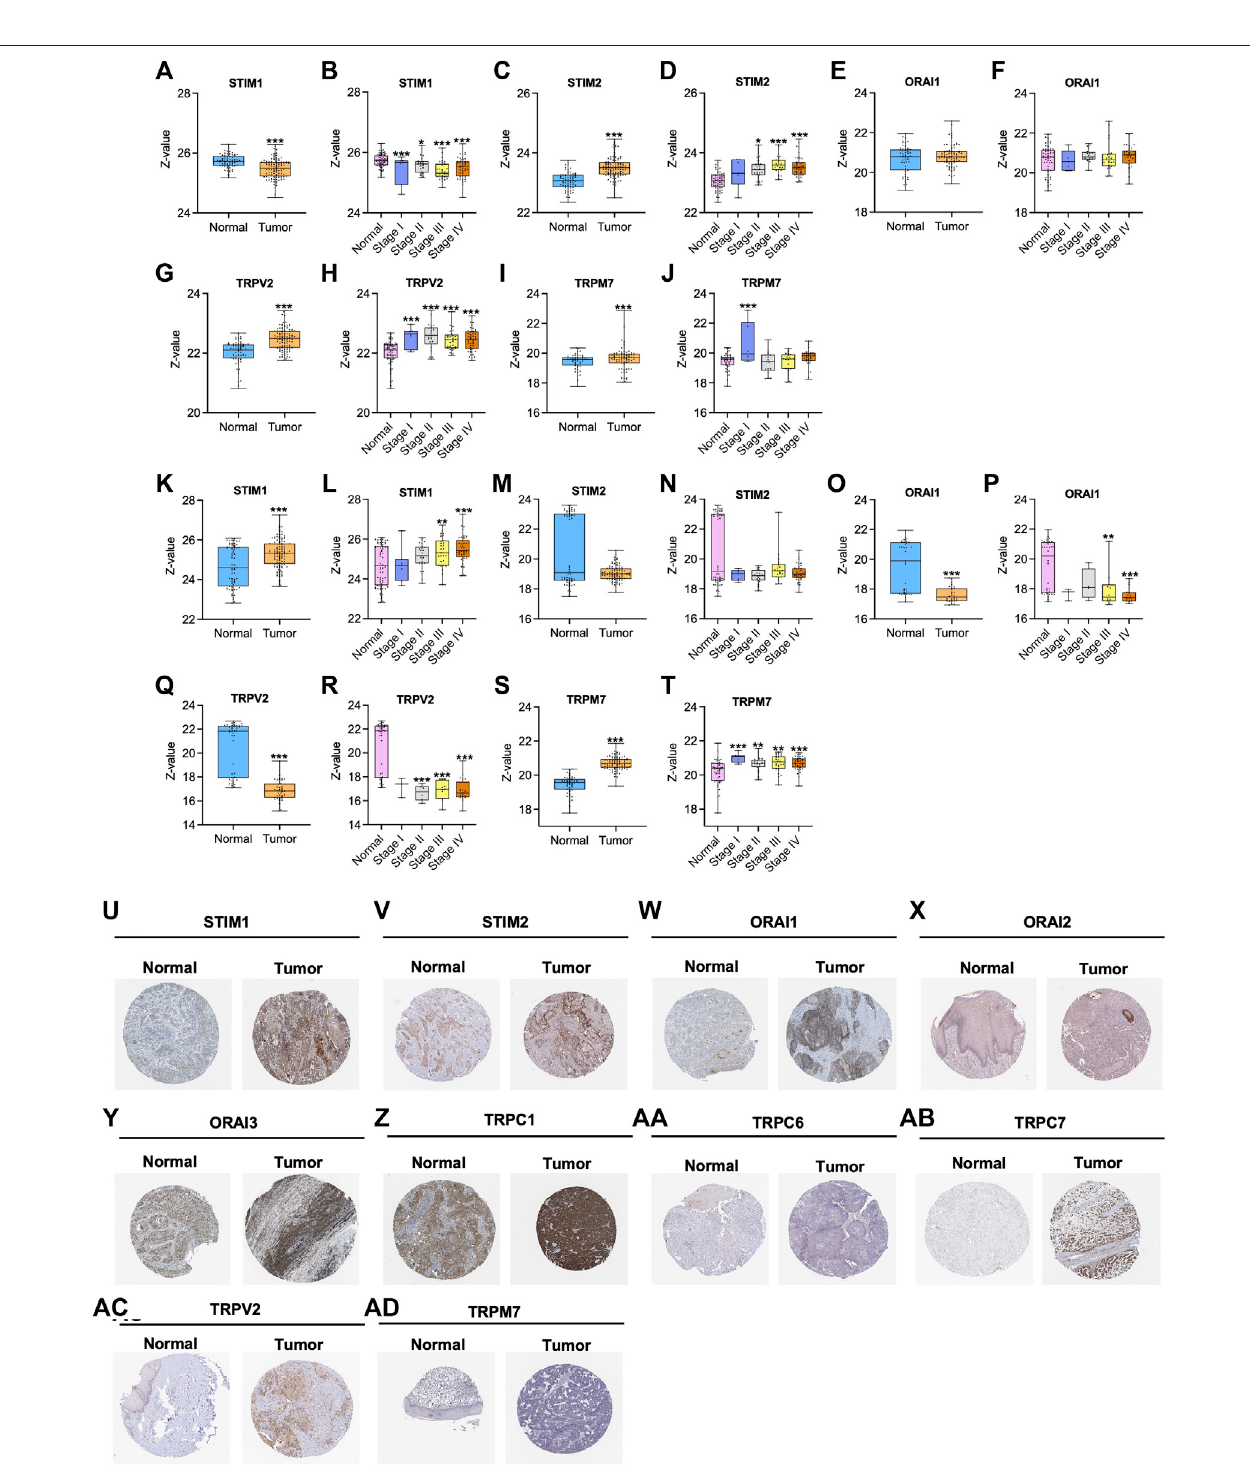
FIGURE9| Alteredprotein expression ofSOCsinHNSC. (A – J) Theproteomics and (K – T) phosphoproteomicsexpression wasdownloadedfromCPTAC-HNSC database using Python 3.0. The protein and phosphoprotein expression of SOCs were plotted. The phosphoprotein sites which are considered to plot this graph include: S257 for STIM1; S261 for STIM2; T295 for ORAI1; S751 for TRPV2; S1477 for TRPM7. Asterisk represents * p < 0.05, ** < 0.01, *** p < 0.001 the statistical signi fi cance. (U – AD) Histopathology slides of tissue microarray were downloaded from Human Protein Atlas and the expression of the SOCs are presented.